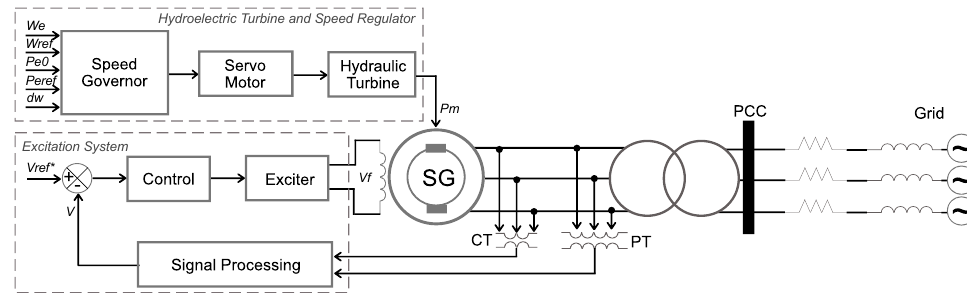
Figure 3. Simplified hydroelectric power plant diagram.